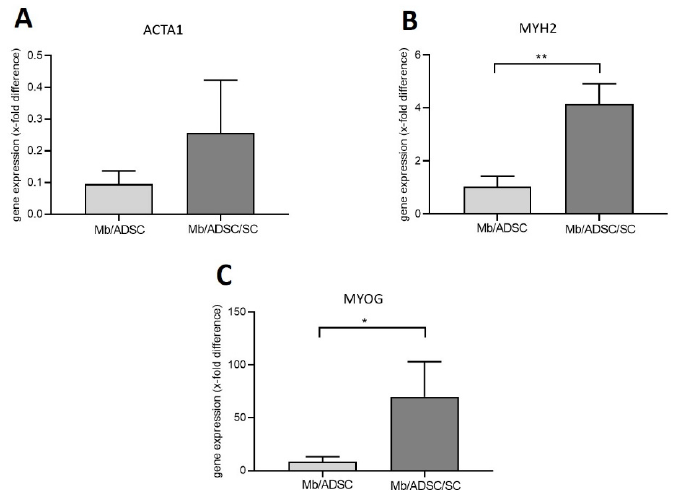
Figure 9. Gene expression of ACTA1 ( A ), MYH 2 ( B ), and MYOG ( C ) in Mb/ADSC vs. Mb/ADSC/SC after 28 days of myogenic differentiation on PCL-collagen I-nanoscaffolds. Expressions are demon- strated in x-fold difference compared with RNA from human muscle tissue using the 2 - ΔΔ Ct method. GAPDH was used as housekeeping gene in co-cultures and muscle tissue. MYOG and MYH2 were upregulated in Mb/ADSC/SC (69.97-fold ± 33.09-fold and 4.169-fold ± 0.756-fold, respectively) compared to Mb/ADSC (8.404-fold ± 4.8-fold and 1.038-fold ± 0.396-fold, respectively). * p < 0.05 (unpaired t -test), ** p < 0.001 (unpaired t -test).